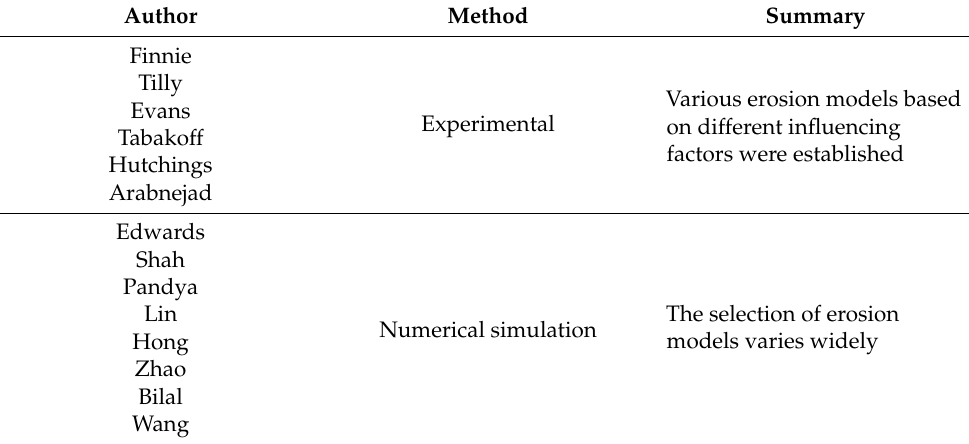
Table 1. Summary of erosion